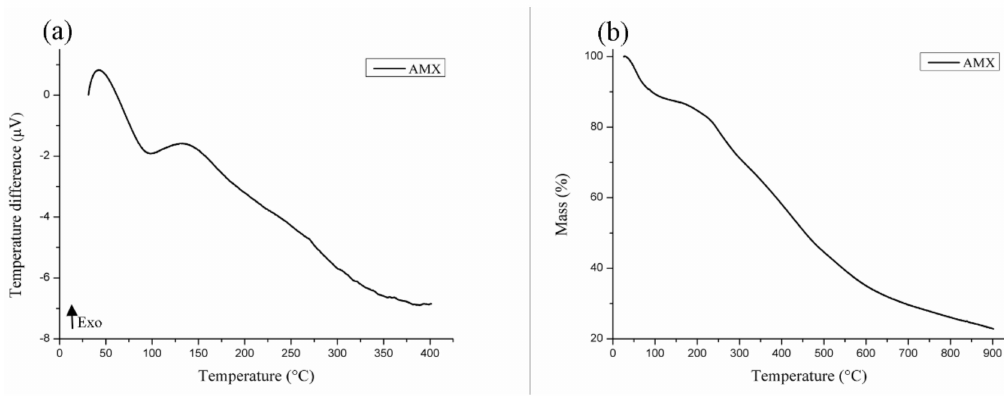
Figure 1. DTA ( a ) and TG ( b ) curves of